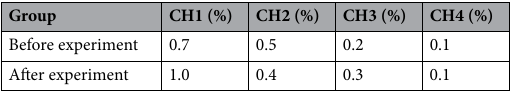
Table 7. The average value of the sensor output signal.